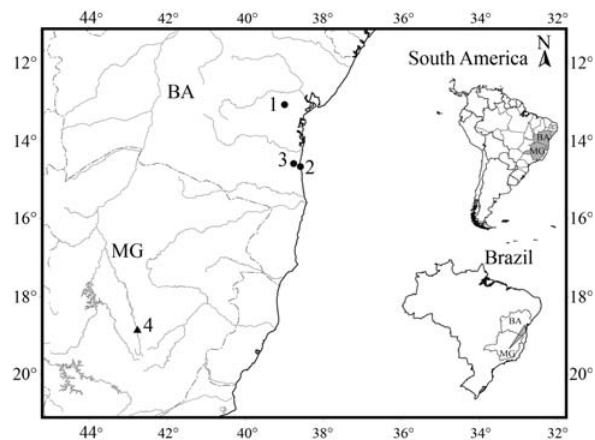
Figure 3 - Geographic distribution of Callistomys : ( (cid:2) ) Callistomys pictus ; ( (cid:2) ) Callistomys sp. 1) The states of Bahia (BA) and Minas Gerais (MG) are indicated on the right in the maps of South America and Brazil. Specific localities in Bahia (1-3) and Minas Gerais (4) are indicated on the leftsideofthemap:1.ElísioMedrado(12°56'47"S,39°31'18"W,390m); 2. Ilhéus (14°47'20" S, 39°02'58" W, 52 m); 3. Rio do Braço (14°40'35" S, 39°15'40" W, 38 m); and 4. Lagoa Santa (19°37'38" S, 43°53'23" W, 760